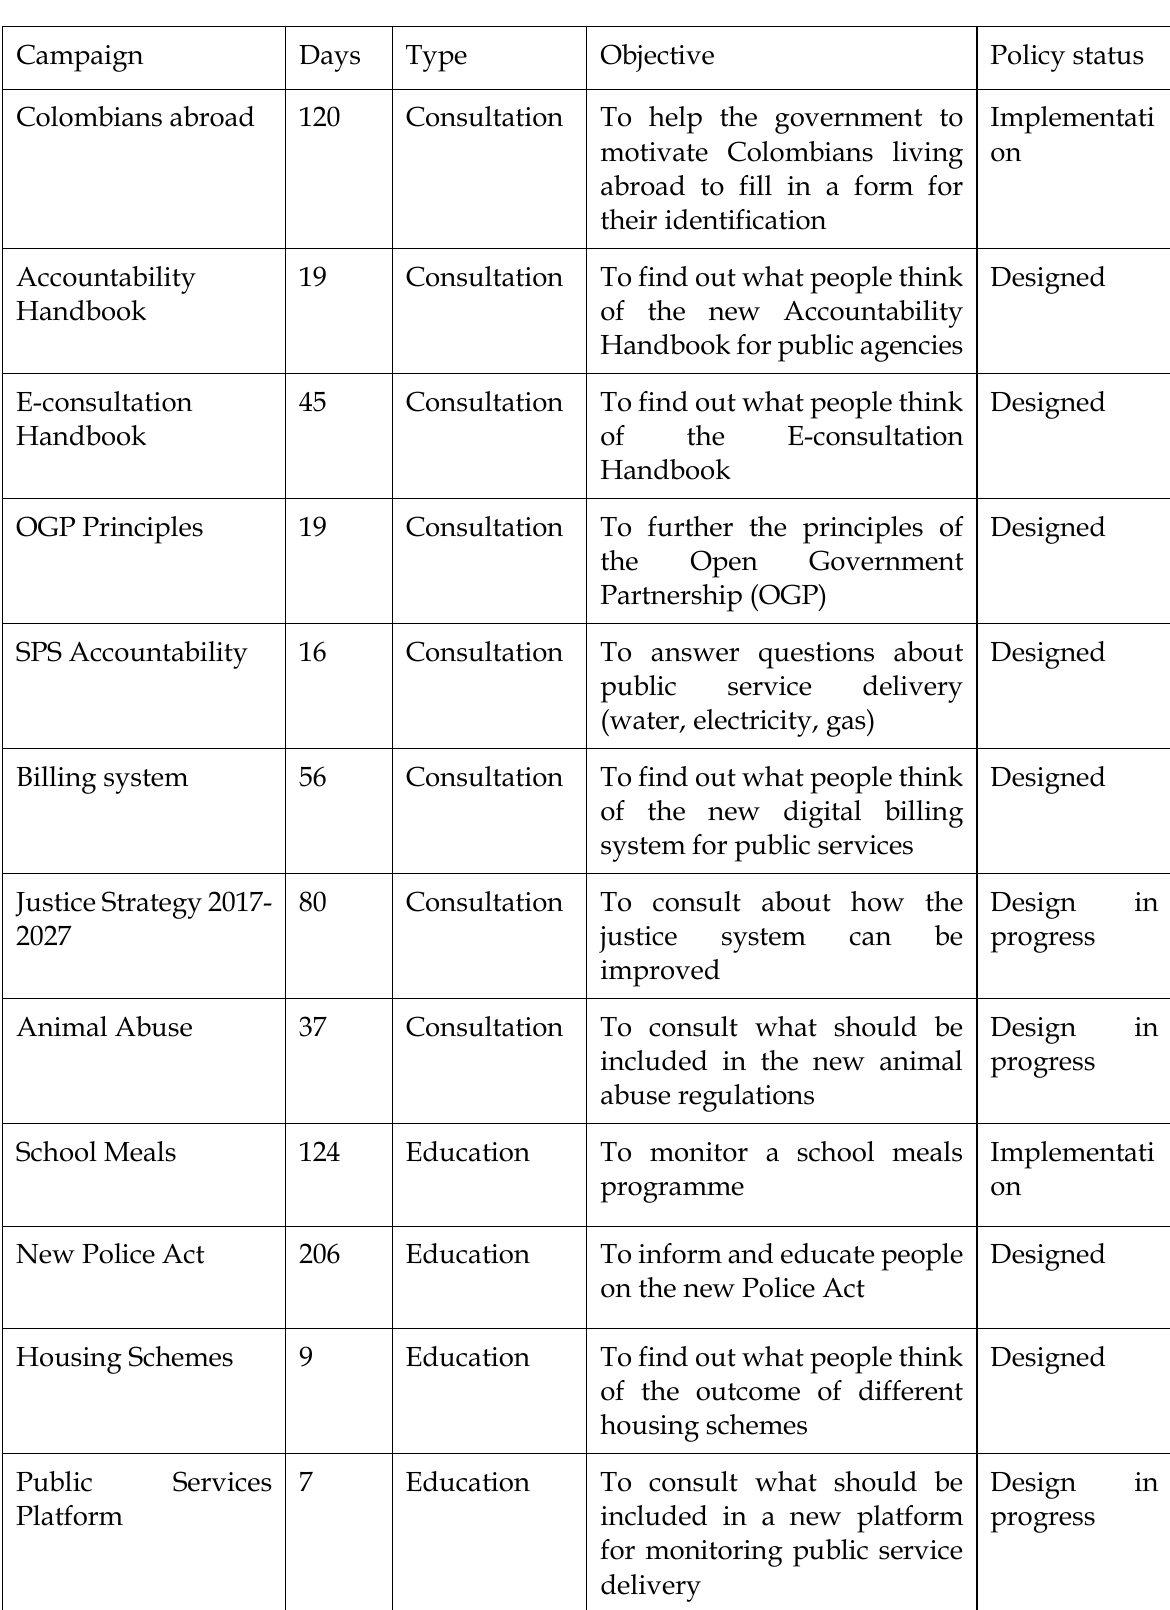
Table 1: Overview of campaigns (Urna de Cristal, 2017)